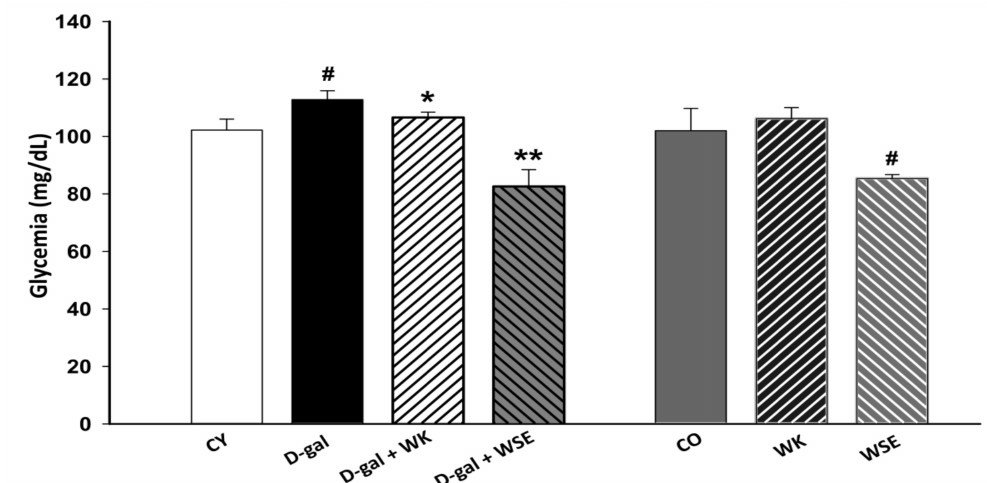
Figure 2. Glycemia levels in D-gal-induced aging and naturally aged rats (values expressed as mean ± SD; n = 8); # p < 0.05 compared to CY or CO; * p < 0.05 in D-gal + WK and ** p < 0.01 in D-gal + WSE compared to D-gal group (CO—control old; CY—control young; D-gal—D-galactose; WK—walnut kernel; WSE—walnut septum extract).